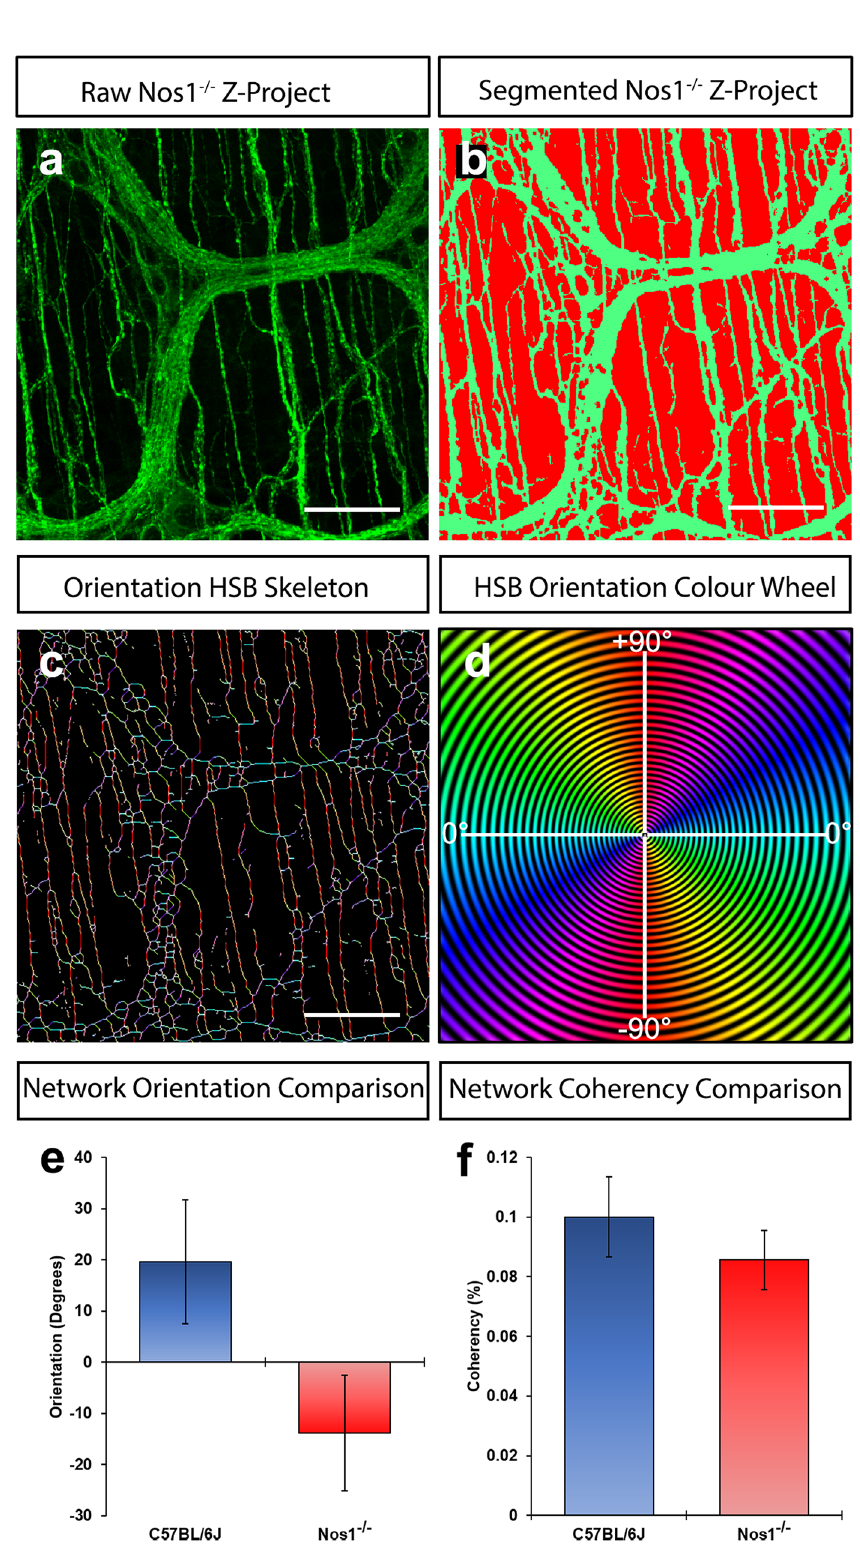
Figure 6. Analysis of TuJ1 network orientation and coherency. ( a ) Representative confocal z-project demonstrating the TuJ1 + (green) network in the Nos1 −/− distal colon. ( b ) Representative image of digitally segmented image in a showing pseudocoloured TuJ1 + neural network (green) and “interganglionic” regions (i.e. background; red). ( c , d ) Representative image ( c ) showing hue, saturation and brightness skeletonised map of network from b psuedocoloured based on 180° hue map scaling ( d ). Hue indicates orientation in degrees (from − 90° to + 90°), saturation indicates coherency and brightness is equivalent to the source image. ( e ) Summary data showing mean orientation of enteric fibres in C57BL/6J (blue bars) and Nos1 −/− (red bars) distal colon. P > 0.05 by Welch’s Student t-test. ( f ) Summary data showing coherency of enteric fibres in C57BL/6J (blue bars) and Nos1 −/− (red bars) distal colon. P > 0.05 by Welch’s Student t-test. Scale bars, 50